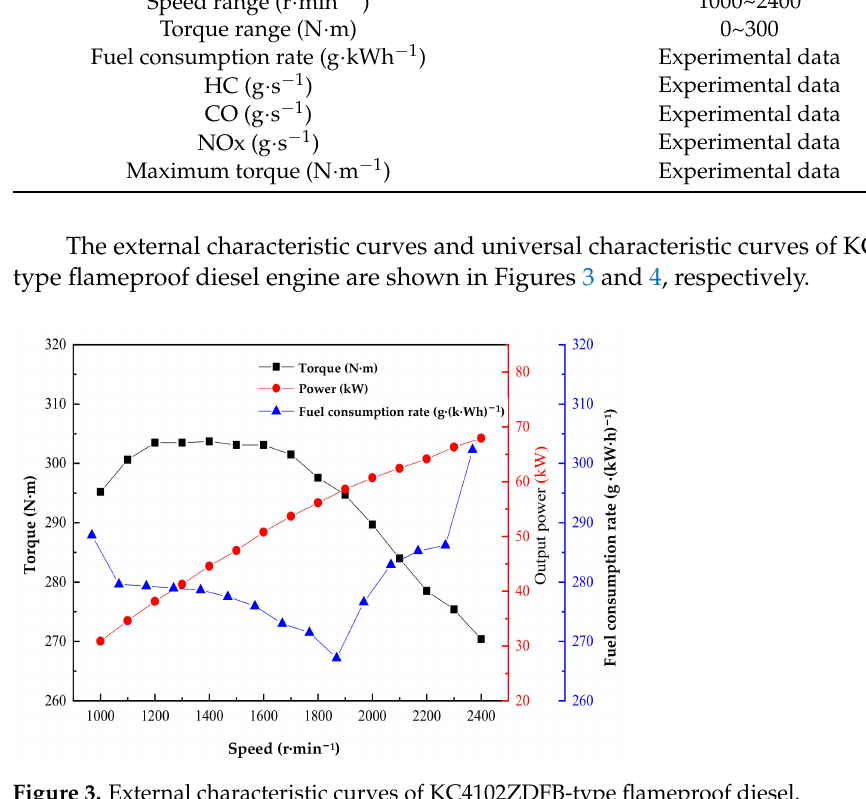
Figure 3. External characteristic curves of KC4102ZDFB-type flameproof diesel.